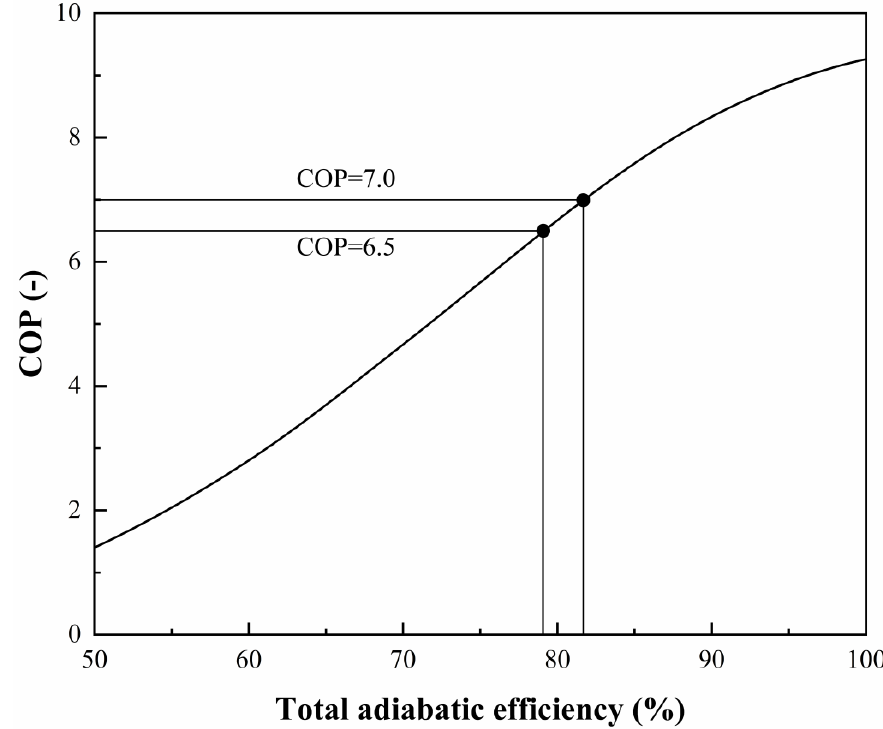
Figure 4. Effect of total adiabatic efficiency of the compressor on COP of the chiller.